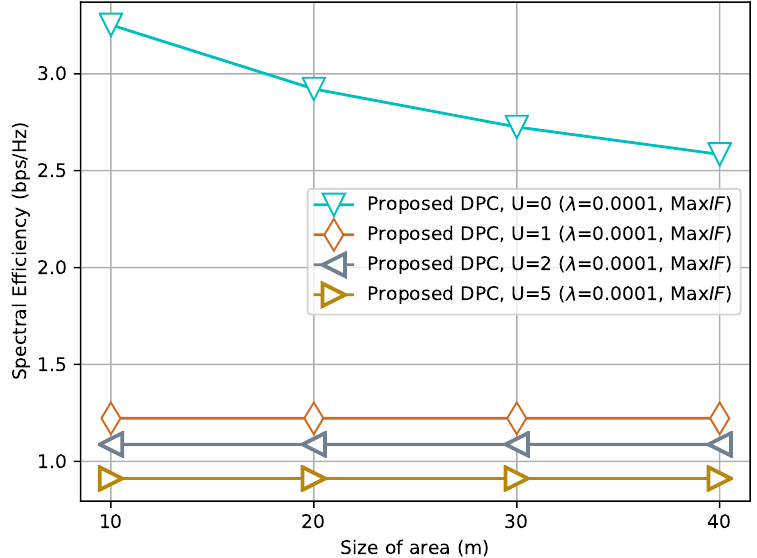
Figure 14. The average spectral efficiency of the proposed scheme for α = 3.8 in Nakagami- m fading channels with m = 3 when the cellular users are in the D2D communication